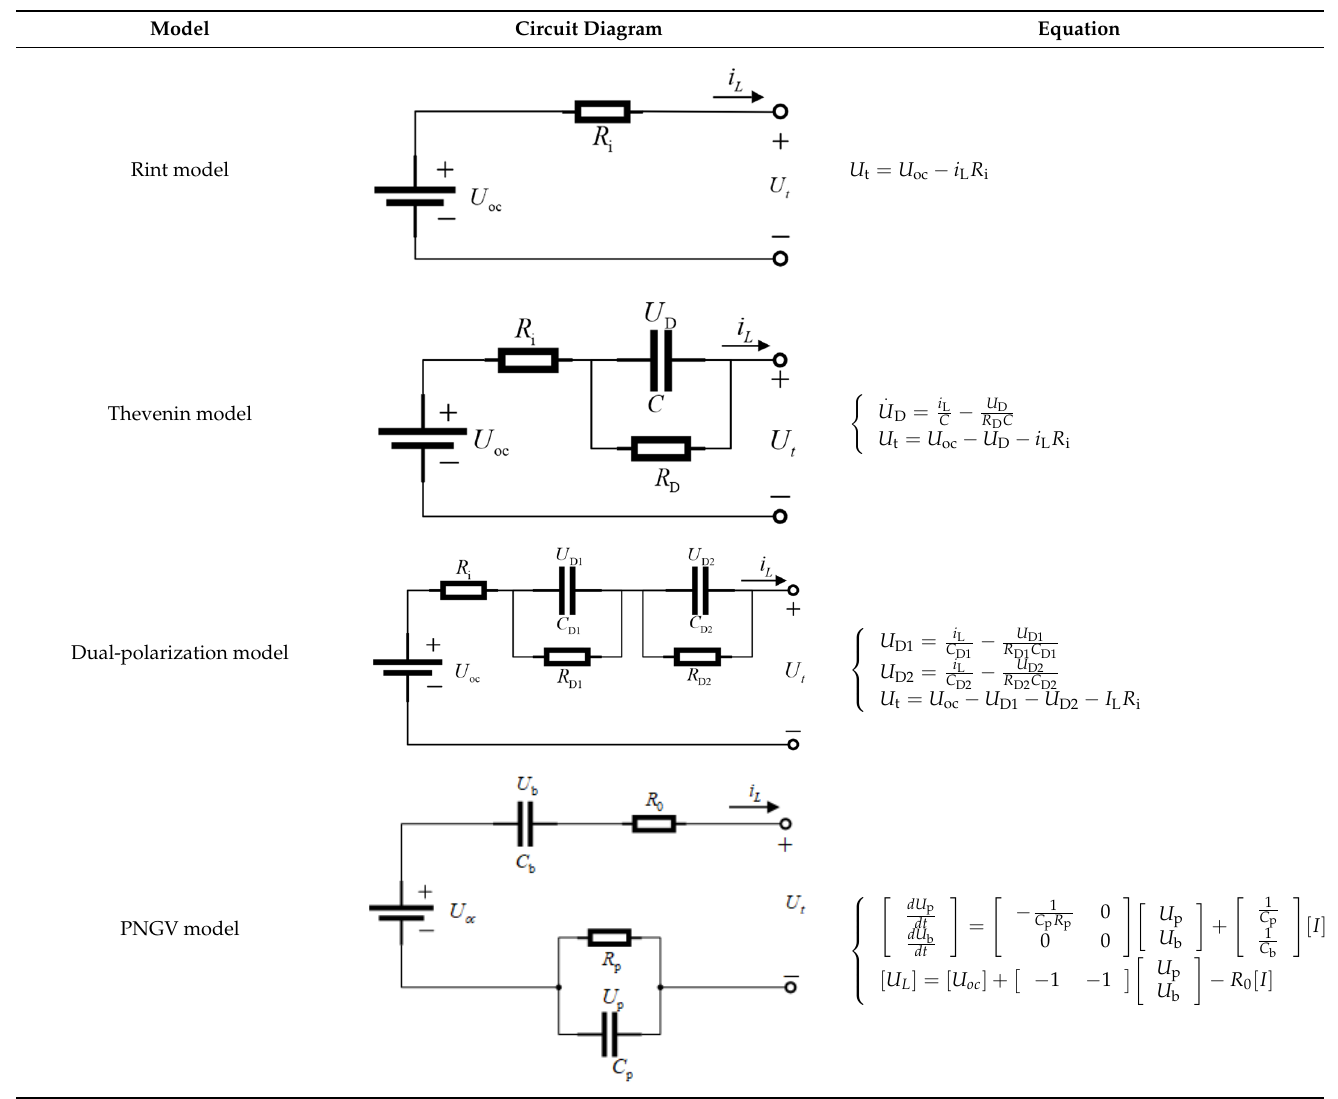
Table 1. Circuit diagram and equation of each model.